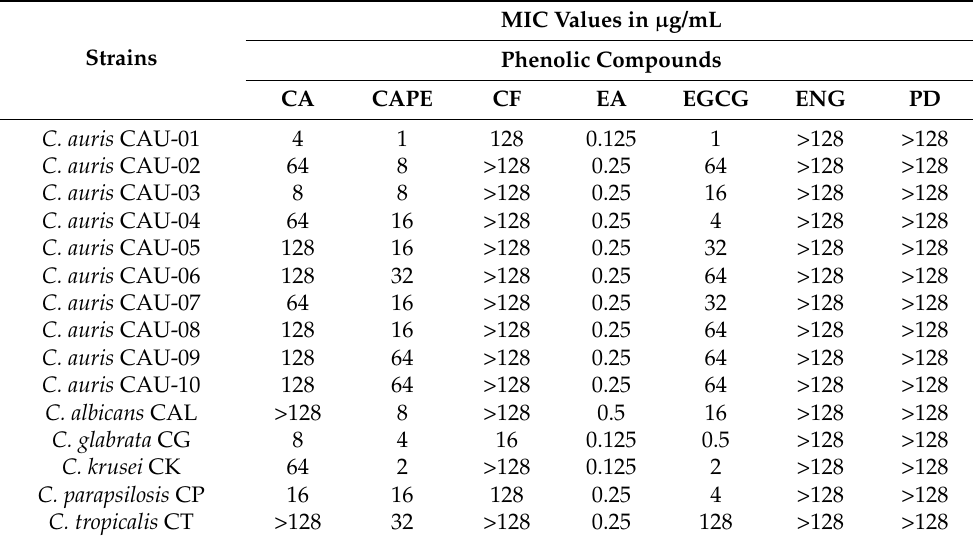
Table 1. Antifungal susceptibility of phenolic compounds against Candida